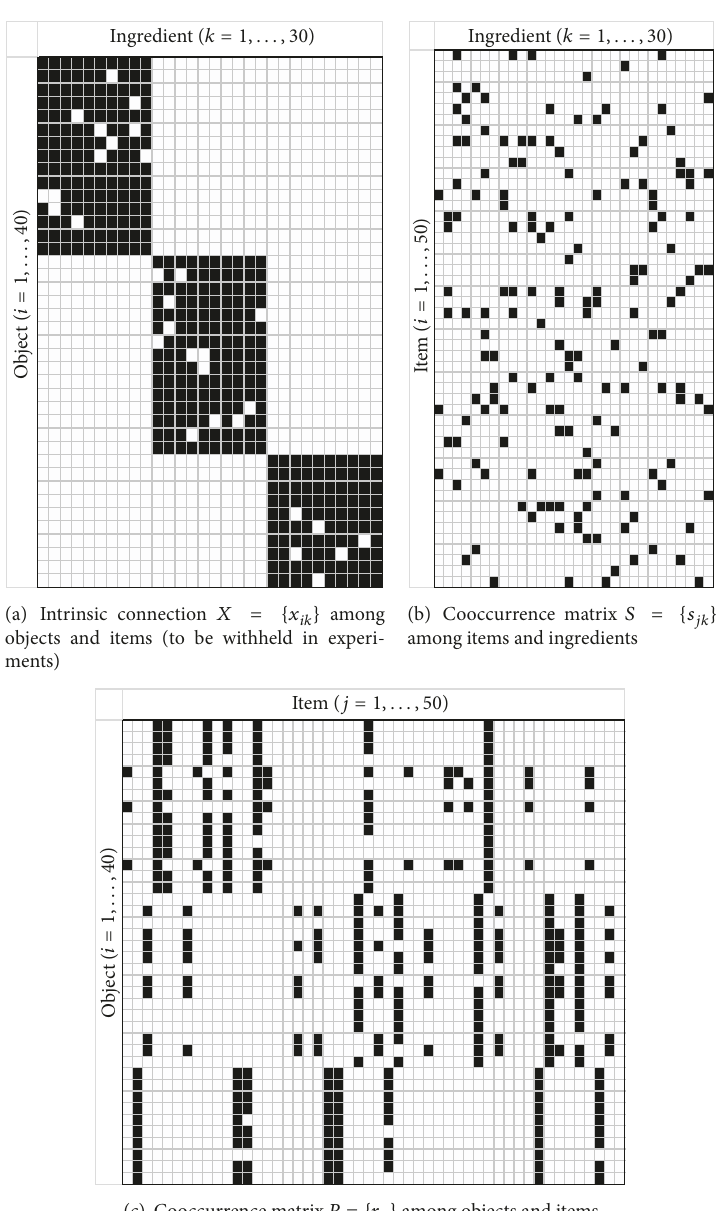
Figure 1: Artificial three-mode cooccurrence information data.